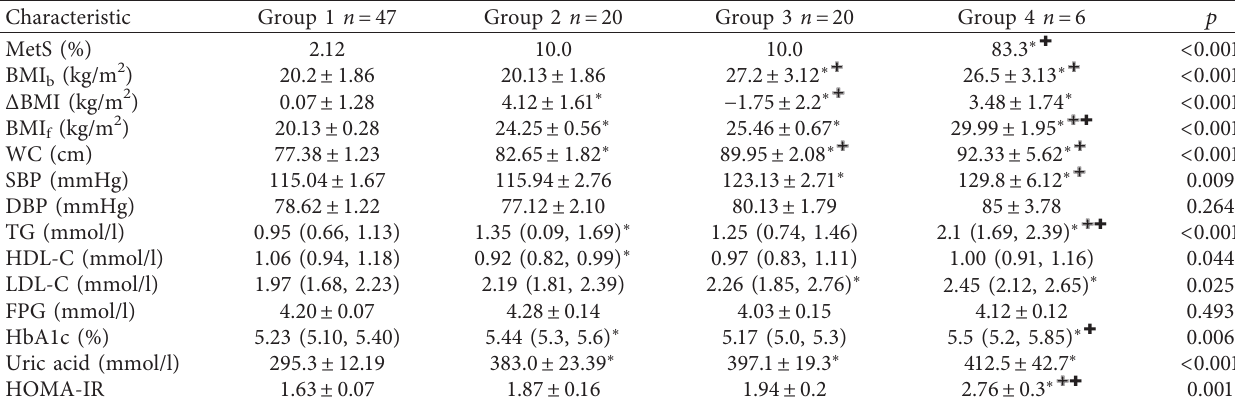
Figure 3: The four groups defined according to baseline BMI (BMIb) and the change of BMI ( Δ BMI) in 5 years. BMI, body mass index; BMIb, the baseline BMI; Δ BMI, the change of BMI. Table 3: Clinical characteristics of the subjects defined by BMI b and Δ BMI after 5 years.